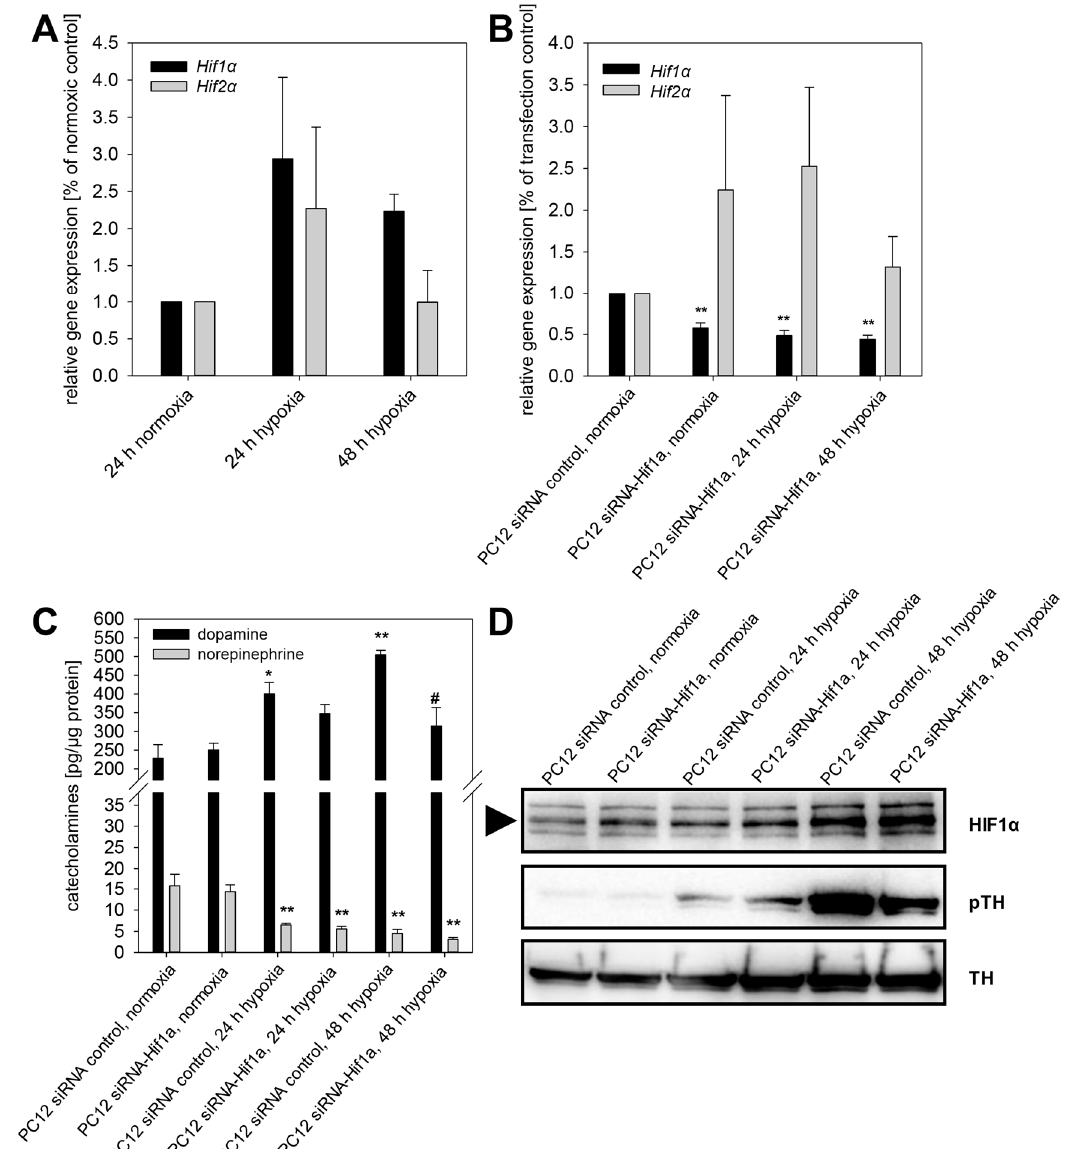
Figure 5. Specific knockdown of Hif1 α diminished phosphorylation of tyrosine hydroxylase and thereby reduced cellular dopamine content in PC12 cells. ( A ) Extrinsic hypoxia led to a time-dependent upregulation of Hif1 α and Hif2 α in PC12. ( B ) RNA interference using siRNA against Hif1 α repressed the expression of Hif1 α also under extrinsic hypoxia while Hif2 α remains unaffected. ( C ) Extrinsic hypoxia increased cellular dopamine content in PC12 control cells (transfection without siRNA). This effect was diminished by knockdown of Hif1 α . ( D ) Furthermore, phosphorylation of TH was decreased by knockdown of Hif1 α . Three independent experiments ( n = 3–6). Mean ± SEM. ANOVA and Bonferroni post hoc test comparison vs. normoxia, * p < 0.05 or, ** p < 0.01, or vs. PC12 siRNA control 24 or 48 h hypoxia, # p < 0.05.